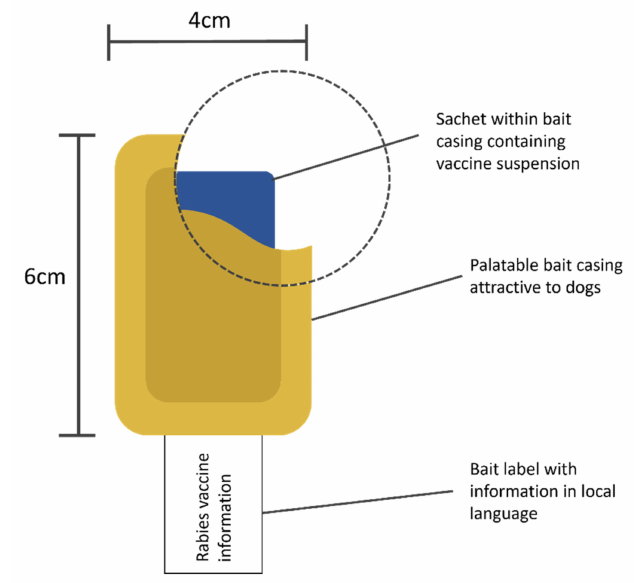
Figure 2. Illustration of components of an example ORV bait construct for use in dogs. The dotted circle shows a cut-away to reveal the impermeable sachet containing vaccine suspension within bait casing. Information is generally either printed directly on the bait casing or as a protruding